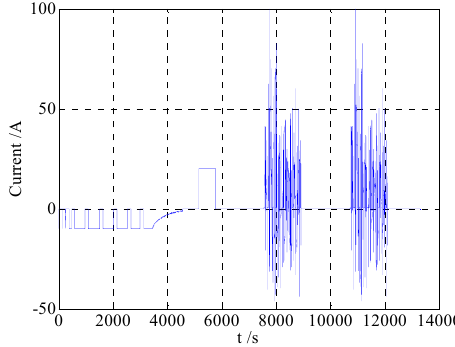
Figure 7. The current profile of the hybrid cycle test.